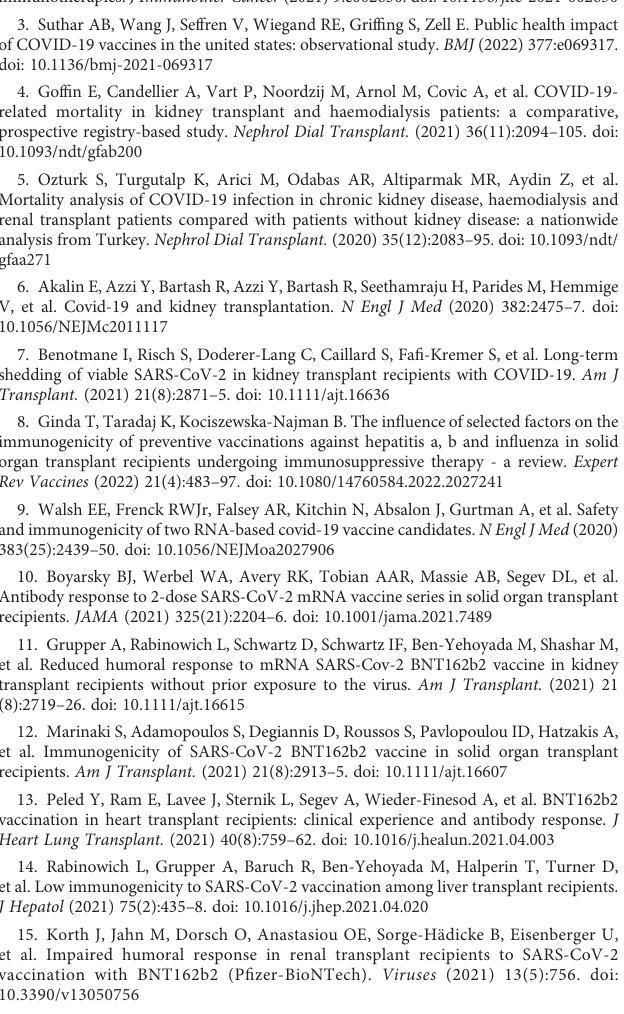
SUPPLEMENTARY FIGURE 1 Individual trends of KTR patients. Levels of anti-Spike IgG antibody (BAU/mL) in KTR(blacklinesandcircles)andHV(bluelinesandsquares)foreachofthepost- vaccination samples. Part of the KTR showed a delay in the generation of Spike- speci fi c IgG at P1 and a higher decrease of IgG levels at P2 compared to